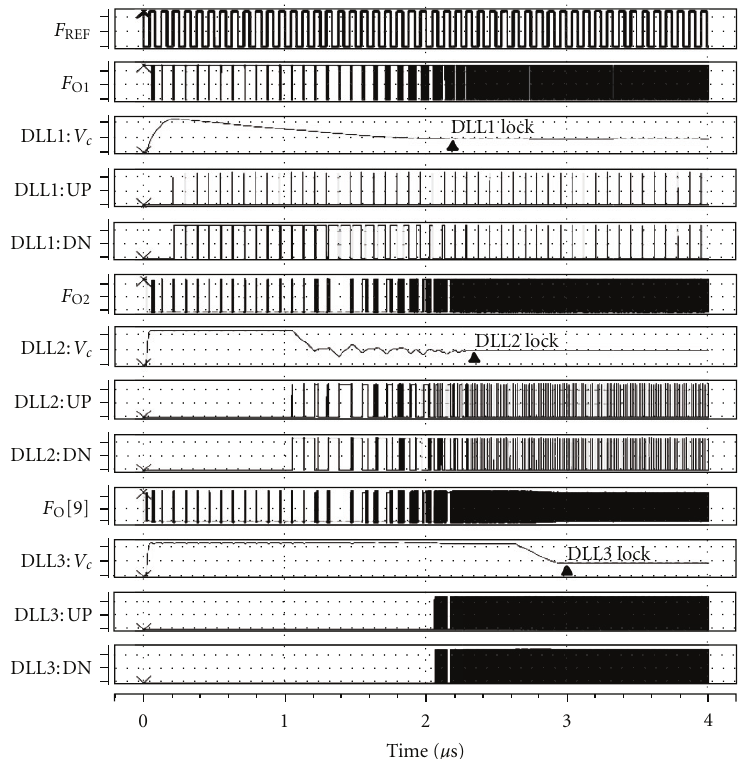
Figure 31: Postlayout simulation results from clock generator wake-up operation. The simulation condition is tt/1.2V/25 ◦ C.